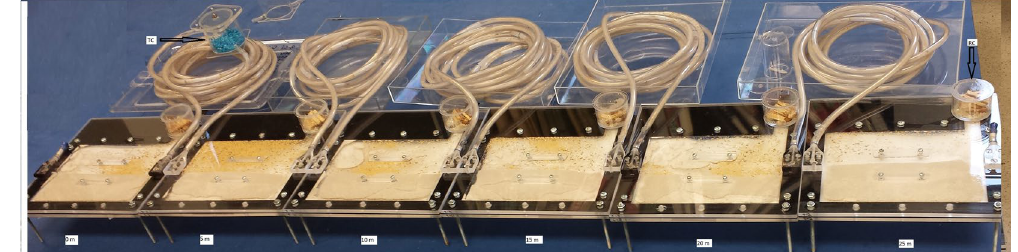
Figure 7. The extended foraging arena was composed of six planar arenas (24 × 24 × 1.4 cm in thickness) filled with moistened sand and connected to each other by a 5 m long coiled Tygon tubing to form a linear distance of 25 m. In the figure, ‘RC’ signifies release chamber and ‘TC’ signifies treatment